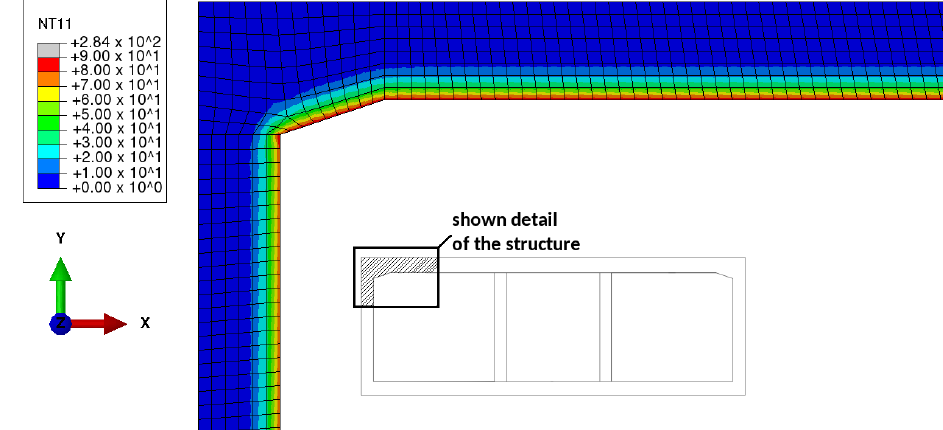
Figure A3. Temperature distribution obtained by prescribing three piecewise uniform surface temperature histories, 30 min after the start of the thermal loading: detail showing the connection of the left wall to the top